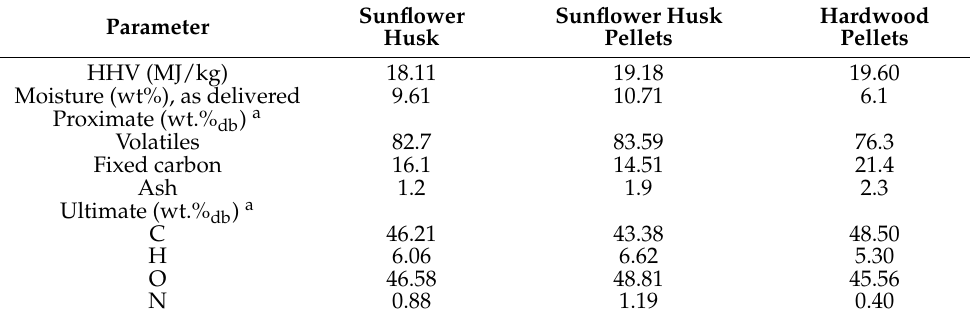
Table 1. Proximate and ultimate analysis of sunflower husk and hardwood pellets. Parameter